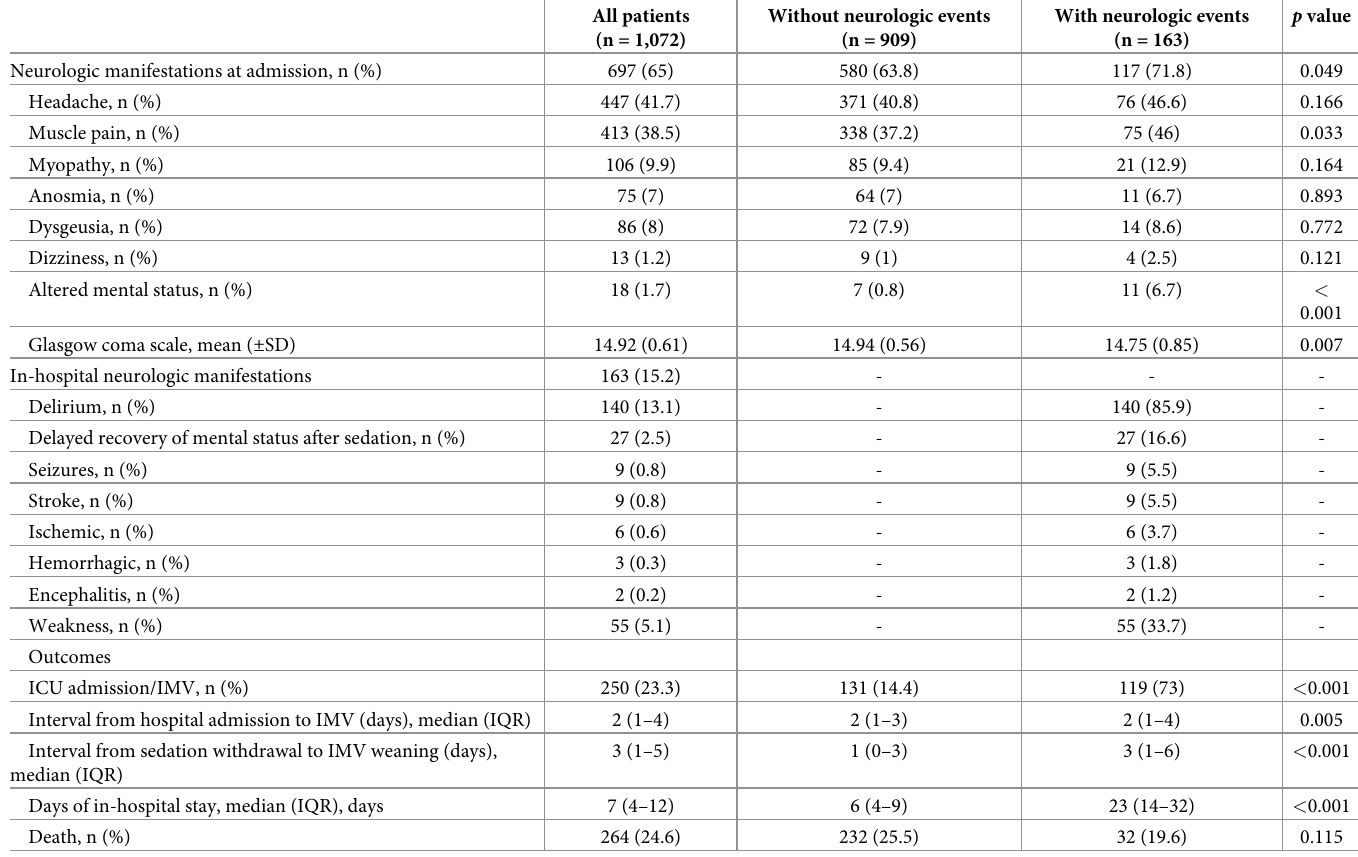
Table 3. Neurologic manifestations and outcomes of the patients hospitalized with moderate to severe COVID-19.